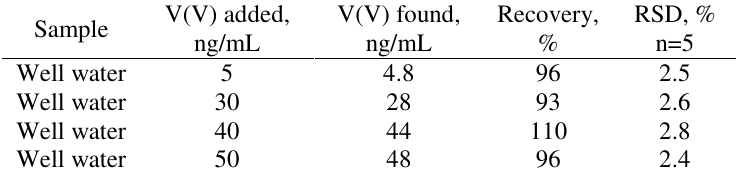
Table 3. Determination of V(V) added to water samples